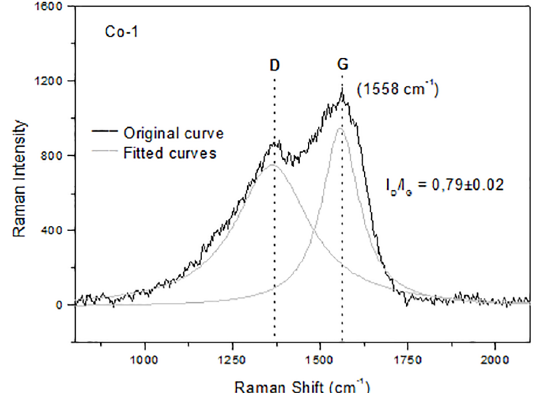
Figure 2. Raman spectrum of Co-1